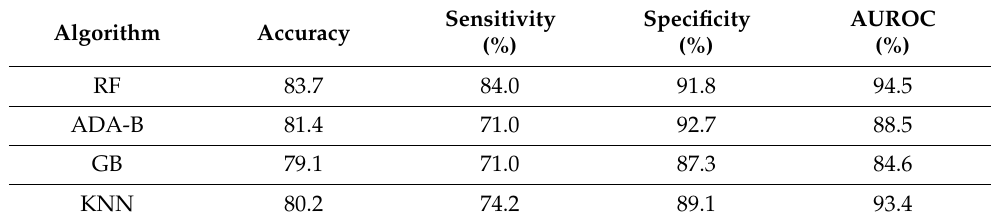
Table 3. Evaluation metrics for each